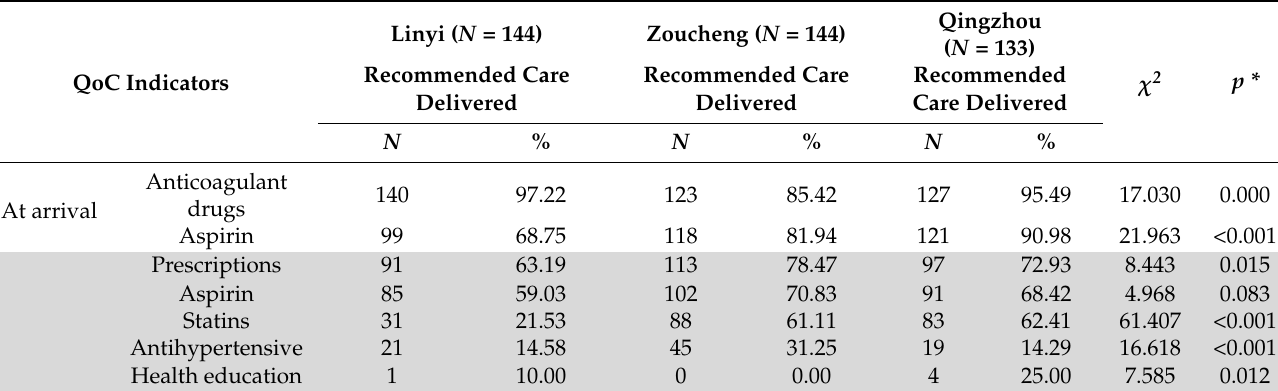
Table 4. Level of QoC for stroke in 3 selected counties ( N =